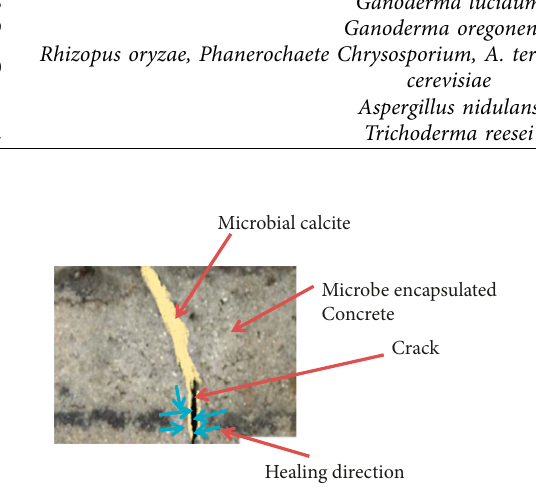
Figure 1: Bacterial self-healing